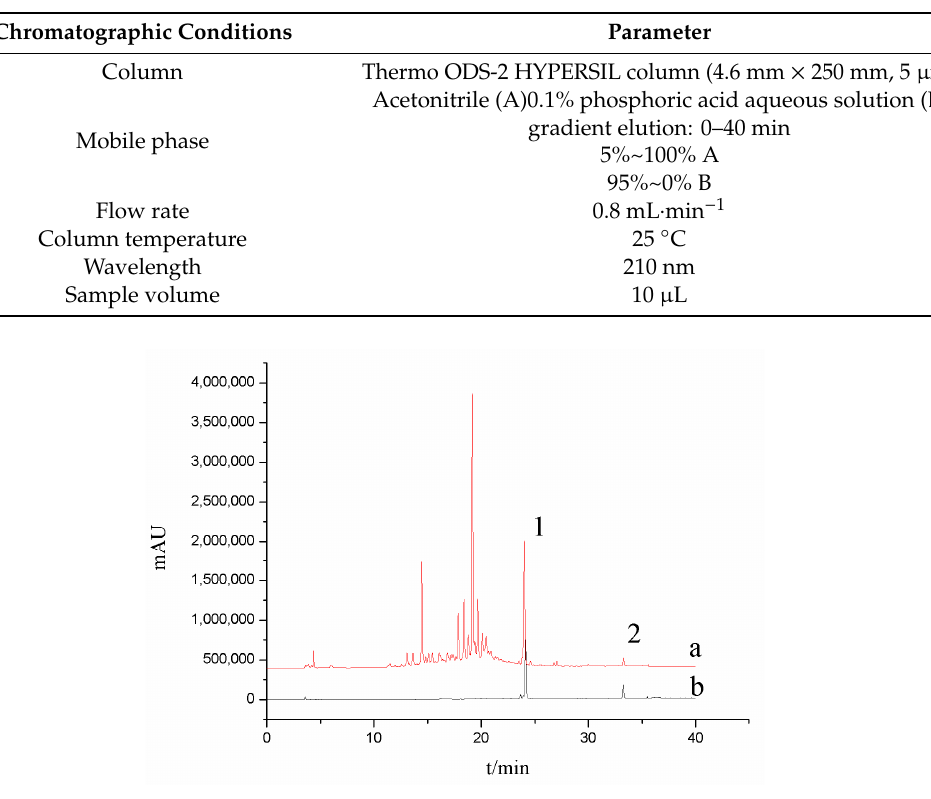
Figure 7. High performance liquid chromatography (HPLC) chromatograms of the test sample solution (a) and the standard solution (b): 1. Compound B , 2. Compound A .